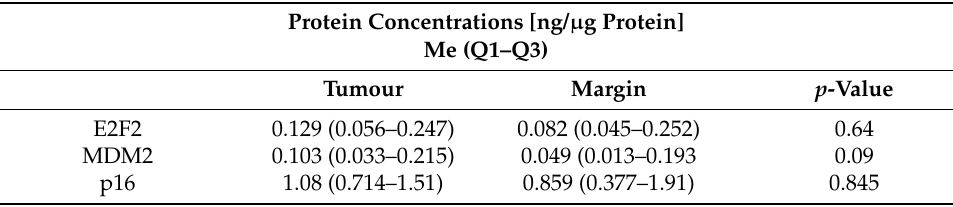
Table 2. E2F2, MDM2 and p16 protein concentrations in tumour samples compared to margin samples. Protein Concentrations [ng/ µ g